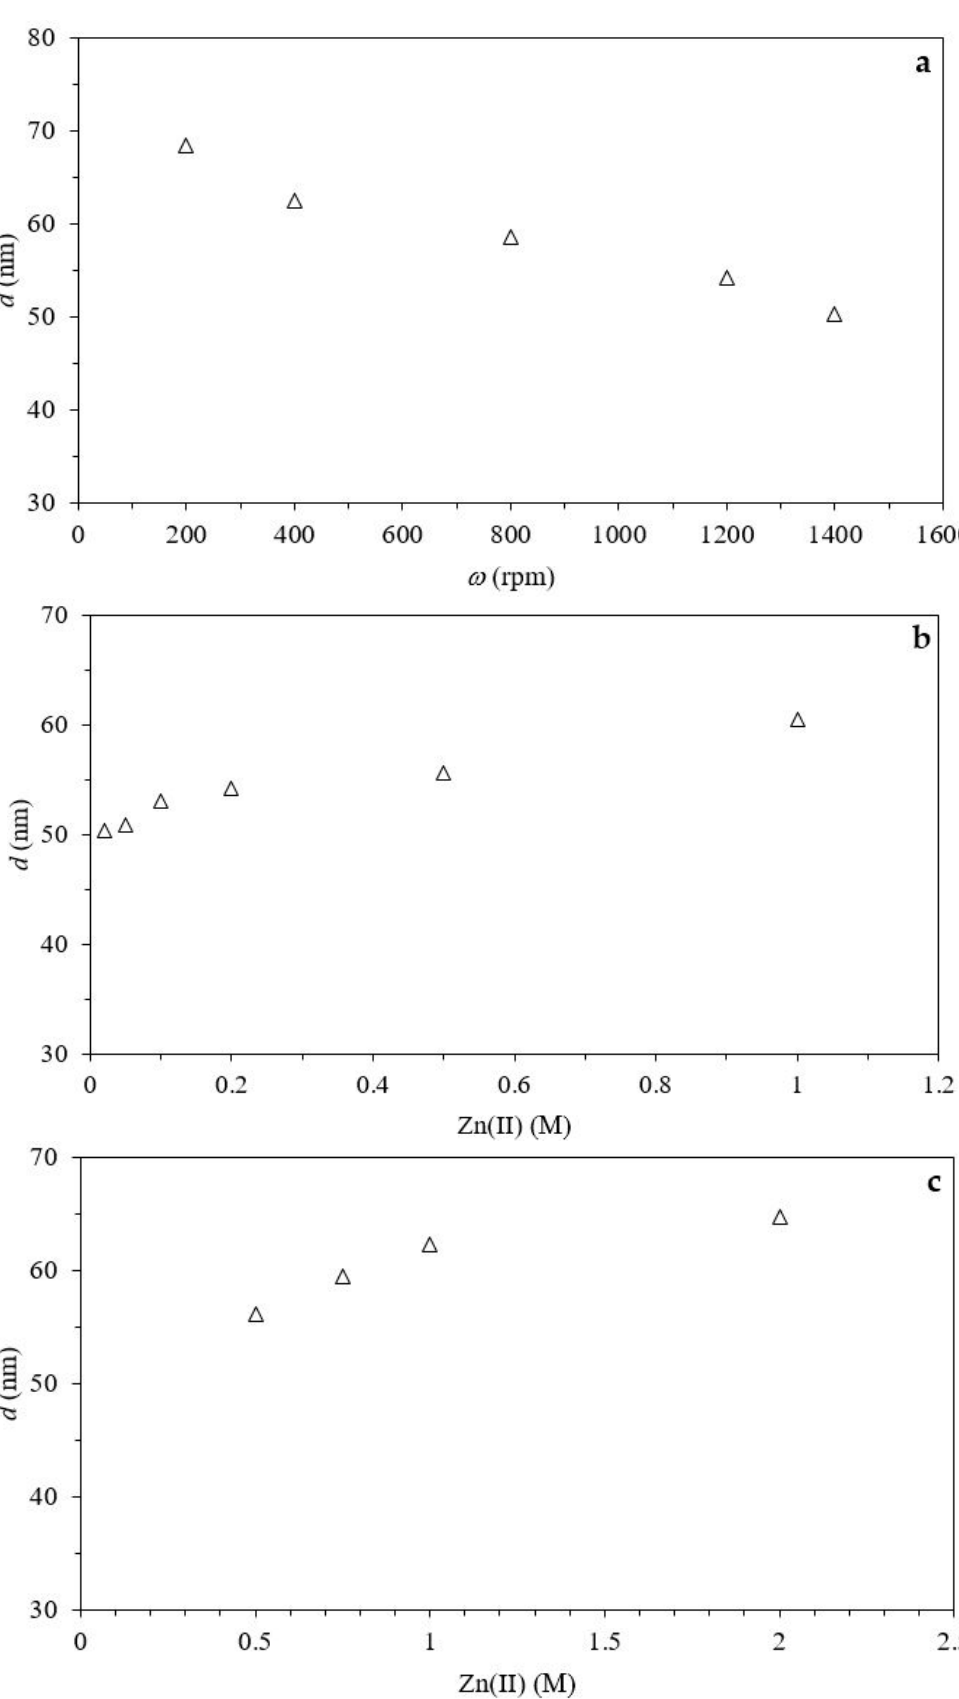
Figure 3. Influence of ω ( a ) and Zn(II)/KOH initial concentration ( b ) and ( c ) on measured d .